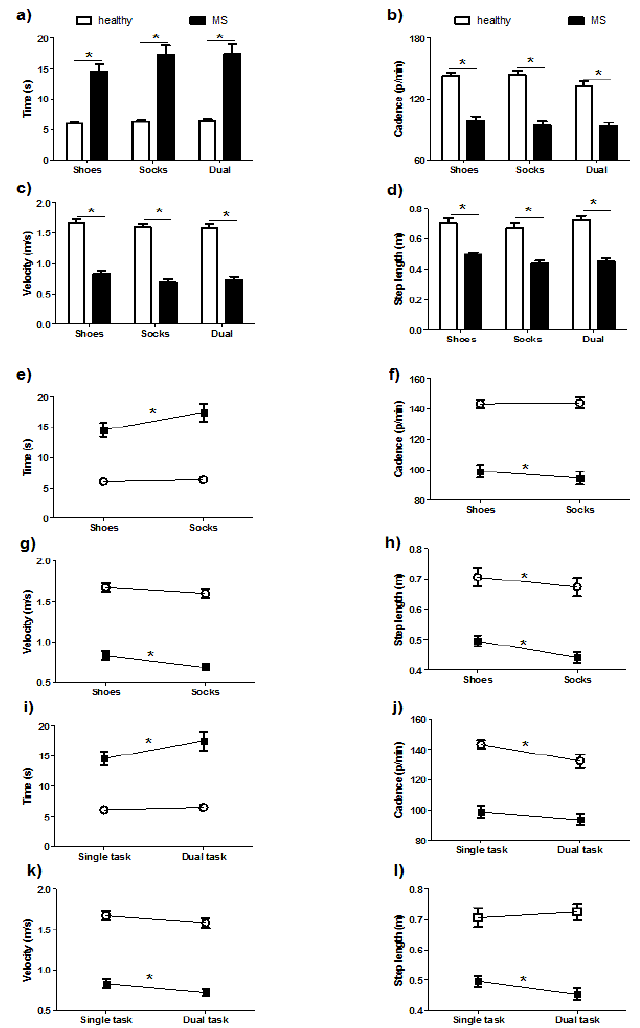
Figure 1. Inter- and intra group comparisons of spatiotemporal parameters. Significant group di ff erences in time ( a ), cadence ( b ), velocity ( c ) and step size ( d ) were found in all three conditions. Intra-group comparison between shoes and socks conditions also showed significant di ff erences in time ( e ), cadence ( f ), velocity ( g ), and step length ( h ) in PwPMS, while only step length in the HCs. For the comparison of single and dual tasks, longer time ( i ), lower velocity ( k ), and shorter step length ( l ) was found when PwPMS were performing a DT compared to performing a single task, while in the HCs only significantly reduced cadence ( j ) was found. *: p < 0.01 in post hoc analysis (( a – d ): between-group comparison; ( j – l ): within-group